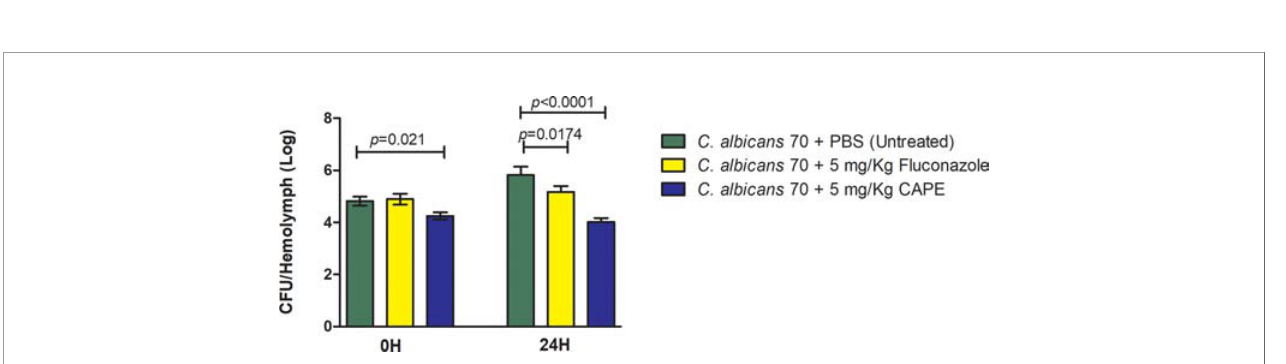
FIGURE 7 | CAPE increased the expression of antimicrobial peptides genes of G. mellonella at 24h after treatment of CAPE. Relative quanti fi cation (log) of galiomicin and gallerimycin for the groups inoculated with PBS (Control), infected with CA70 only (untreated), treated with CAPE, and infected and treated with CAPE [CA70 + CAPE (5 mg/Kg)]. Gene expression was represented as mean and SD. Normalization was done using b -actin gene. Different letters A, B, C and D represent statistically signi fi cant differences among the groups. ANOVA and Tukey Tests ( p < 0.05).